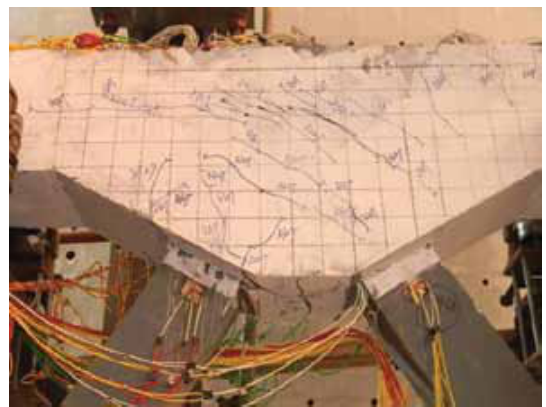
Fig. 8. Distribution of cracks on ZHJD-2 concrete surface P = 3500